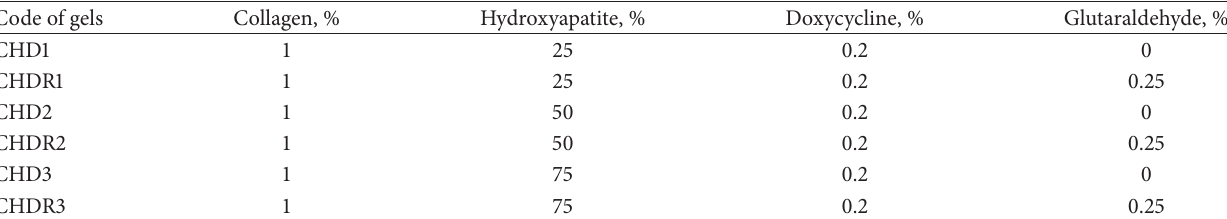
Table 1: Composition and name of collagen